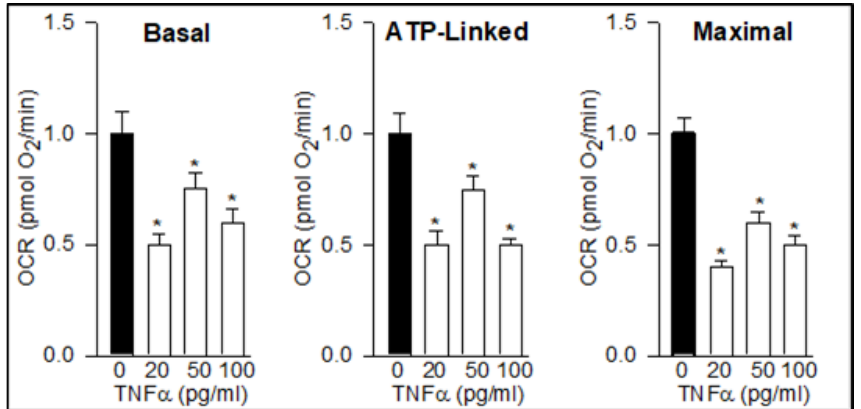
Figure 1. TNF α Impairs NPC Mitochondrial Function. Hypothalamic NPCs were treated with various doses (20, 50, and 100 pg/mL) of TNF α in complete medium for 24 h. Basal, ATP-linked, and maximal respiration were determined. Values are normalized to untreated control cells and expressed as fold change (Mean ± SEM of n = 4 independent experiments with each treatment performed in duplicate). * p < 0.05 vs. untreated cells.